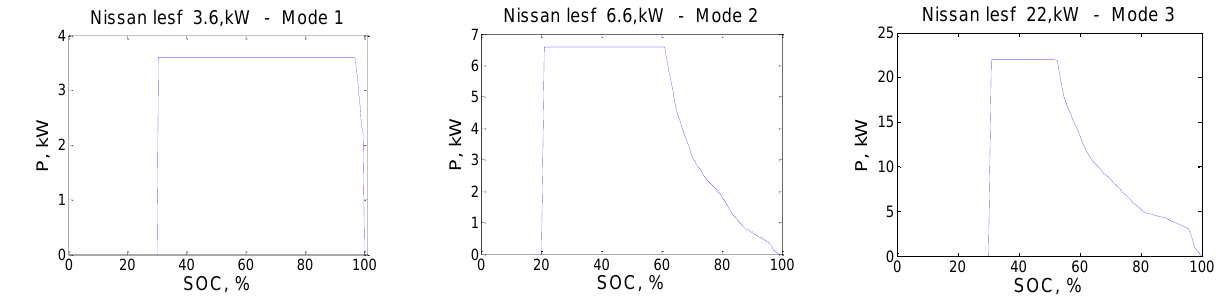
Figure 5. Different charging cycles of Nissan Leaf.